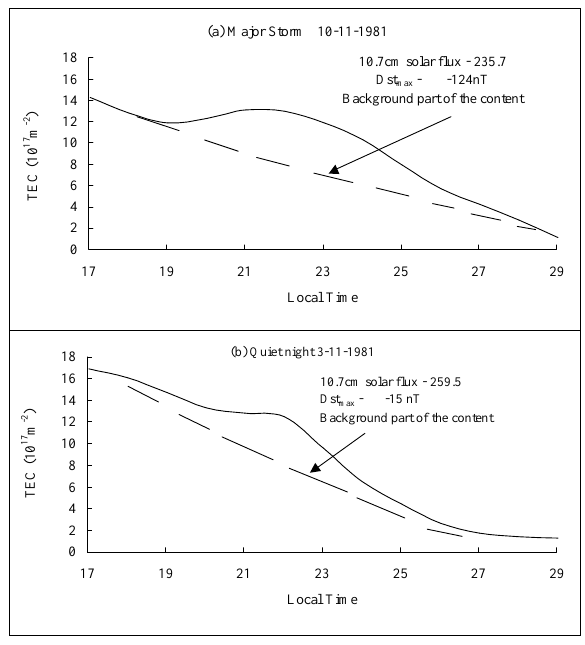
Fig. 1. Typical examples of night-time TEC variations during (a) major storms and (b) quiet